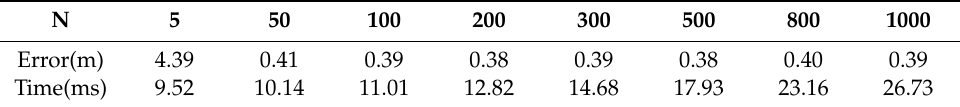
Table 5. E ff ect of particle numbers N on localization accuracy and running time. Table 5. Effect of particle numbers N on localization accuracy and running time.